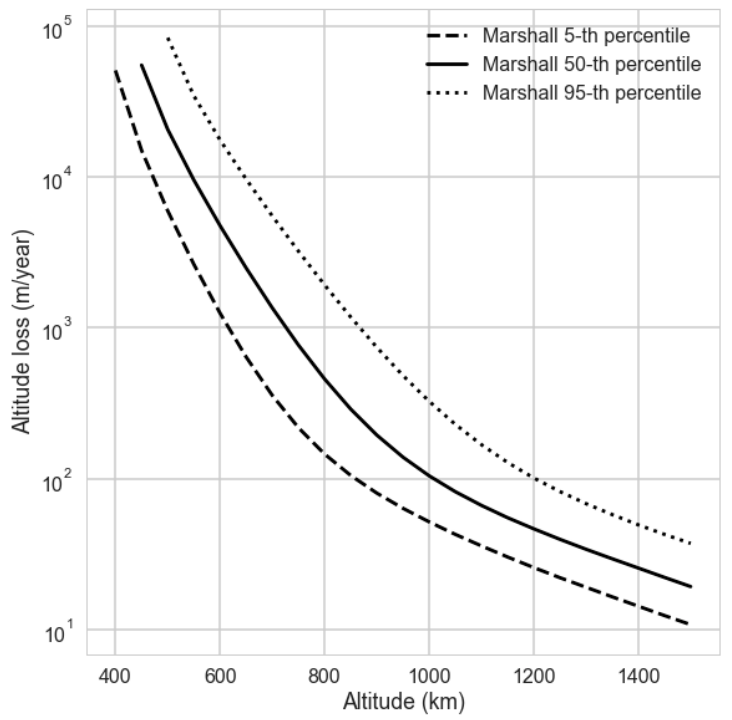
Figure 13. Approximate altitude loss (m/year) for an arbitrary satellite as a function of the initial altitude (km). Three scenarios are provided: three solar flux scenarios: 5-th percentile (weak solar activity, dashed), 50-th percentile (median solar activity, plain) and 95-th percentile (intense solar activity, dotted).